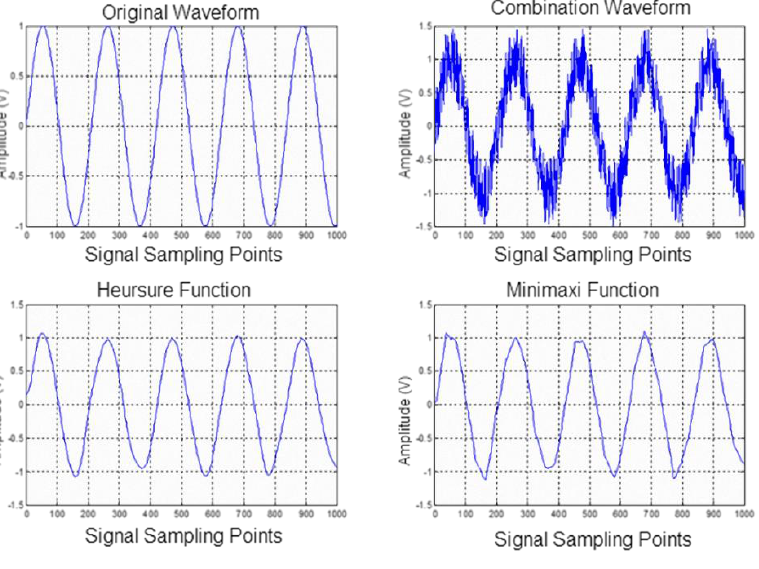
Figure 3. Processing effects of wavelet de-noising for the same case with different threshold values ( M =